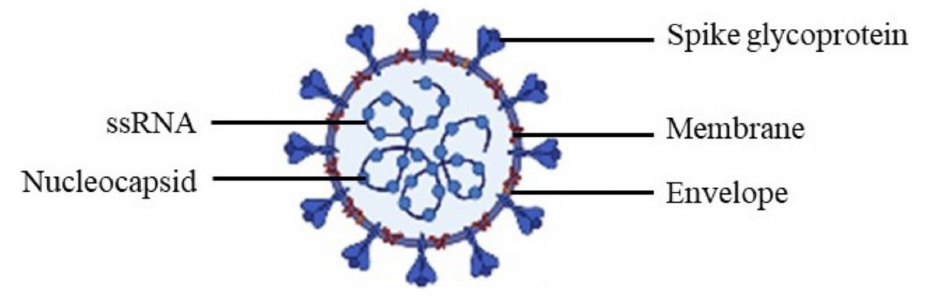
Figure 1. Schematic diagram of the coronavirus virion.